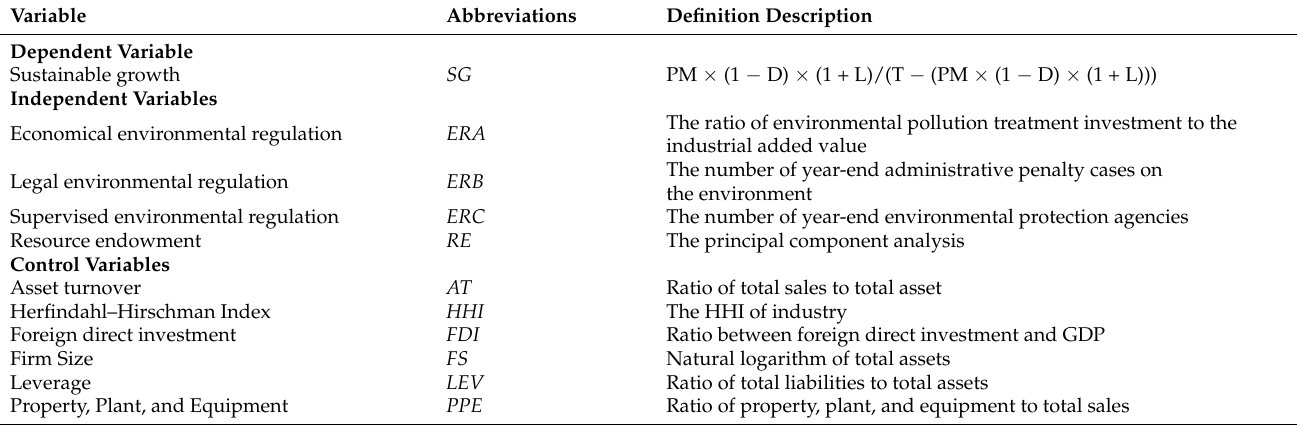
Table 1. Variables and